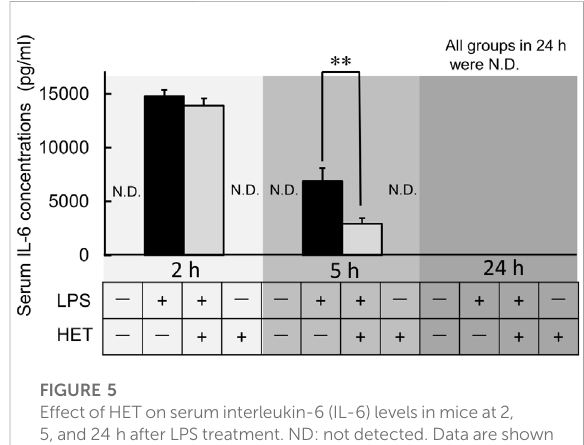
FIGURE 5 EffectofHETonseruminterleukin-6(IL-6)levelsinmiceat2, 5, and 24 h after LPS treatment. ND: not detected. Data are shown as mean ± SEM; n = 6 – 10 per group. **: p < 0.01 (vs. LPS).